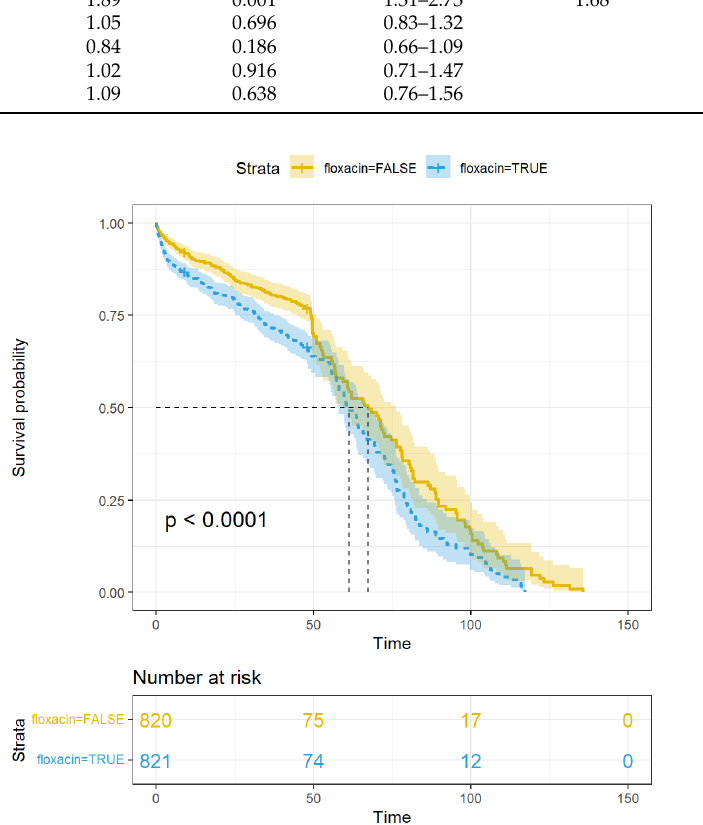
Figure 3. Kaplan – Meier survival curve of patients in FQ and non-FQ group: patients in FQ group Figure 3. Kaplan–Meier survival curve of patients in FQ and non-FQ group: patients in FQ group haves worse survival than non-FQ group. haves worse survival than non-FQ